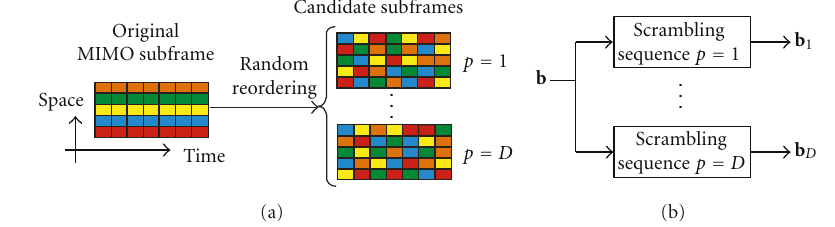
Figure 2: Mapping methods: (a) symbol reordering, (b) symbol